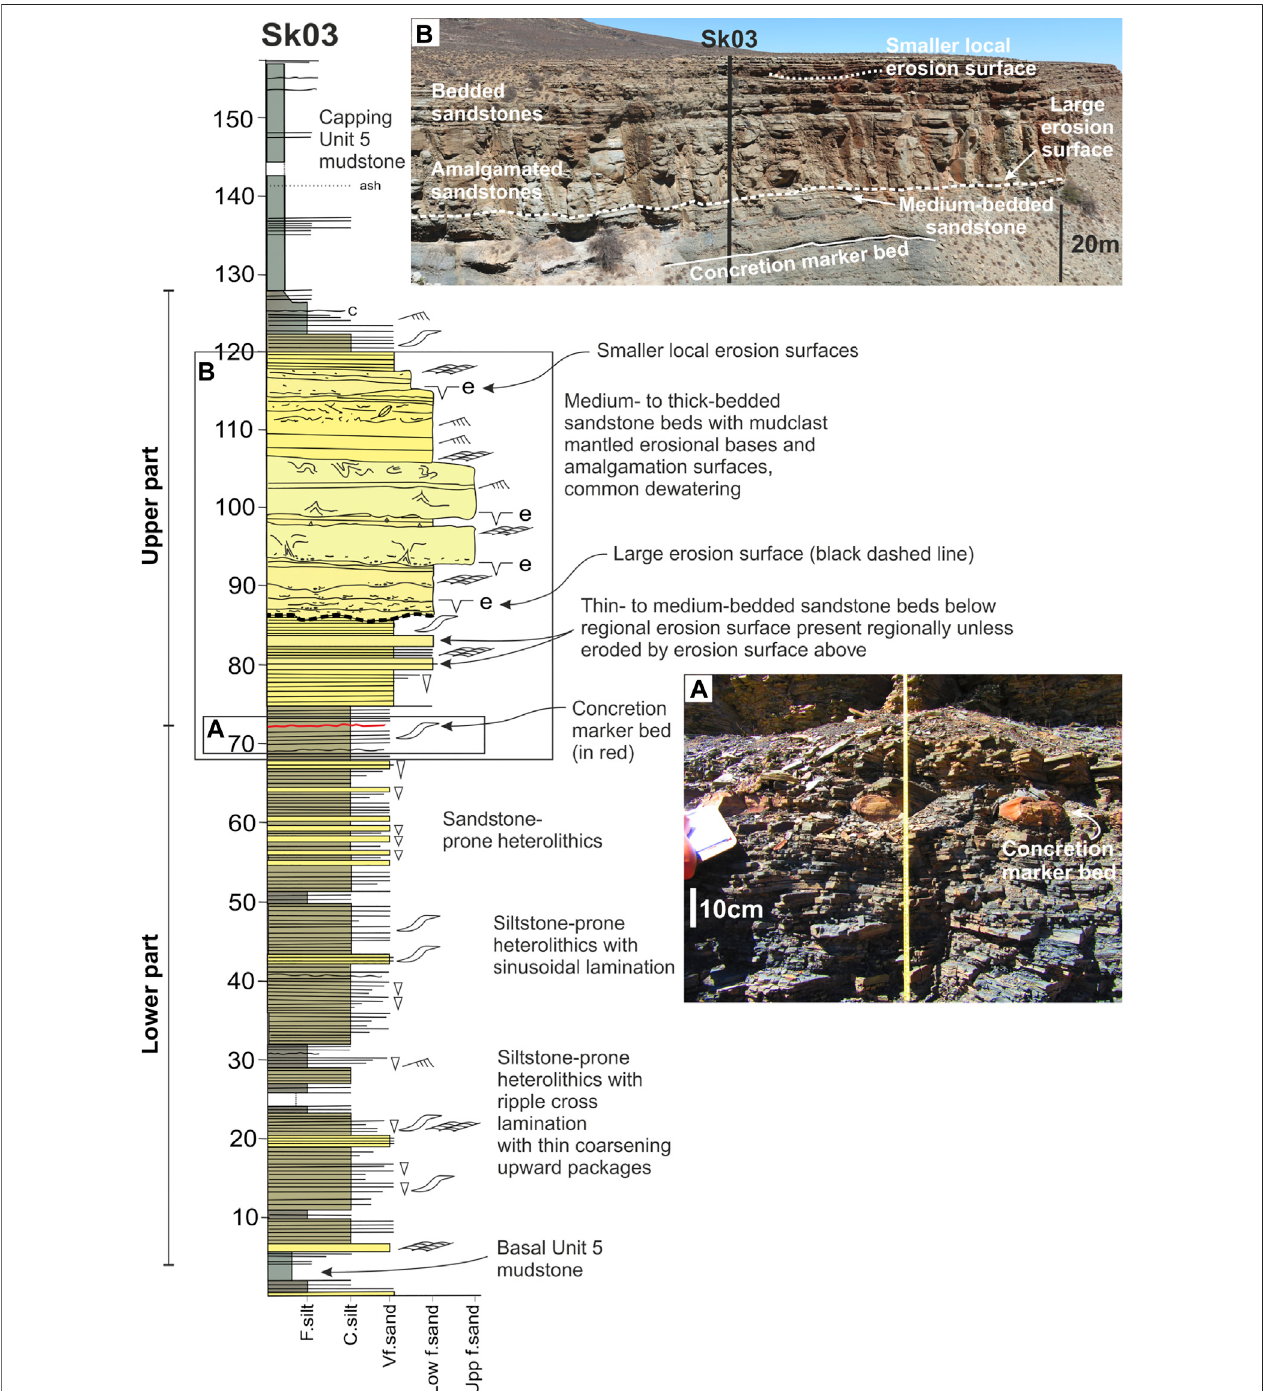
FIGURE 4 | Log SK03 showing an overview of the Unit 5 stratigraphy with the lower thin-bedded and upper sandstone-prone parts. The concretion marker bed and regional erosion surface are highlighted by a red solid and black dashed line respectively. (A) Photo of the thin-bedded succession with concretion marker bed. (B) Photo of log SK03 showing the concretion marker bed and the medium-bedded sandstone beds below the regional erosion surface. The sandstone fi ll of the large erosion surface can be seen as well as a small erosion surface towards the top of this fi ll.